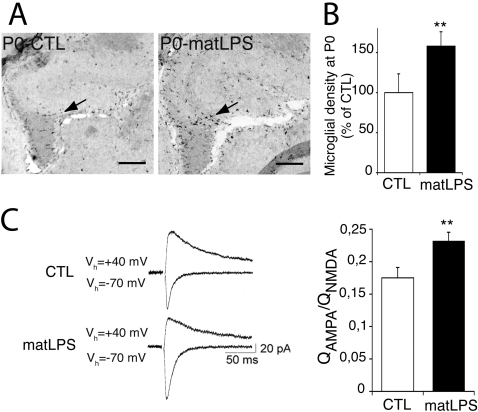
Maternal exposure to LPS induces microglial activation at birth and synaptic alterations in the adult offspring.(A) F4/80 labeling of microglia (arrows) in the hippocampus of P0 born from control (CTL) or LPS-injected dams (matLPS). (B) Quantification of microglial density in the hippocampus at P0. Between 4 and 15 pairs of matched slices were counted per experiment, n = 4 experiments; **p<0.001, two-way ANOVA. Scale bar: 100 µm. (C) Increased ratio of excitatory AMPAR and NMDAR currents in hippocampal slices of adults born to control (CTL) or LPS-injected (matLPS) dams. Left, original traces from individual experiments. Right, averaged data from n = 9 CTL and 10 matLPS experiments; **p<0.02.